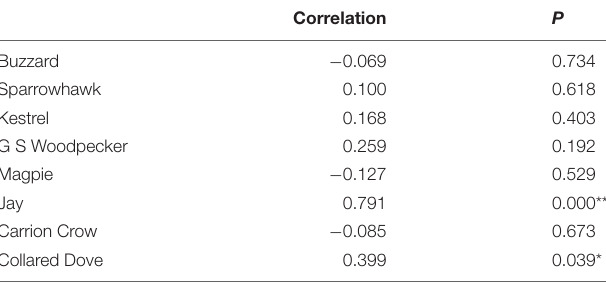
TABLE 5 | Correlation between effect sizes reported in Newson et al. (2010) and current study.